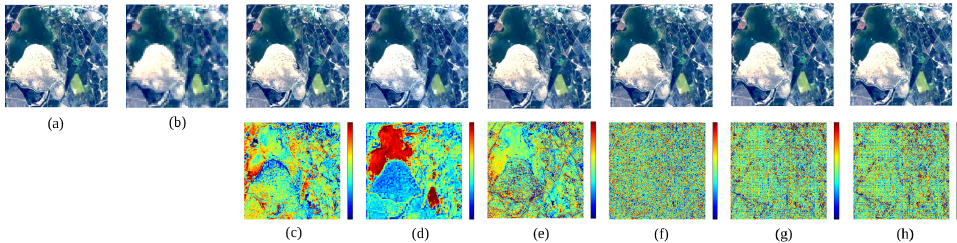
Figure 11. Comparison of fusion results on the Sand Lake dataset. ( a ) Reference Image; ( b )